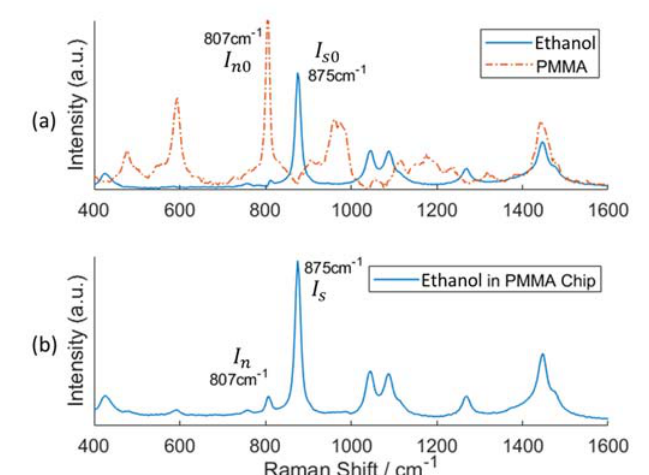
Figure 8. ( a ) Raman spectra of ethanol and PMMA measured by commercial Raman microscope (Bruker Senterra at the Department of Chemistry of Ghent University), and ( b ) Raman spectrum of ethanol in the PMMA chip obtained with our setup using a 200 μ m diameter MMF fiber. The PMMA background is suppressed with a factor of 6. (figures are in the same scale).